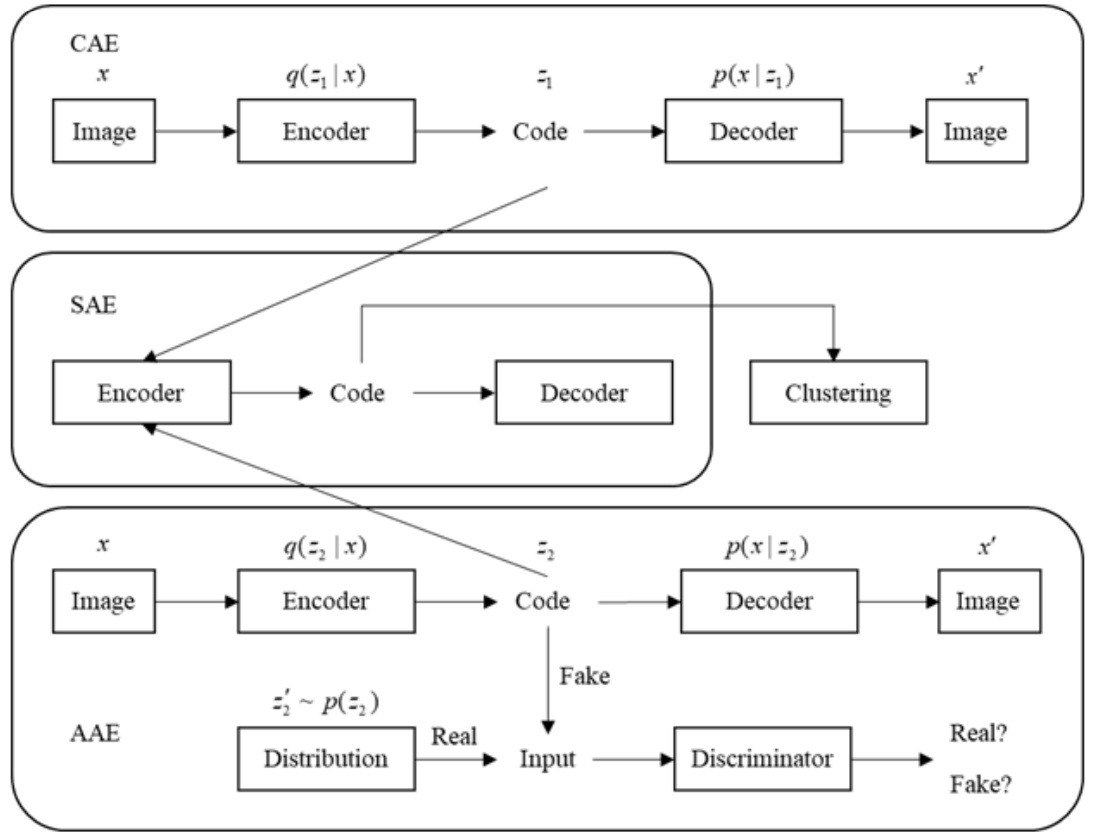
Figure 2. Structure of the hybrid autoencoder. CAE: convolutional autoencoder; SAE: stacked autoencoder; and AAE: adversarial autoencoder.